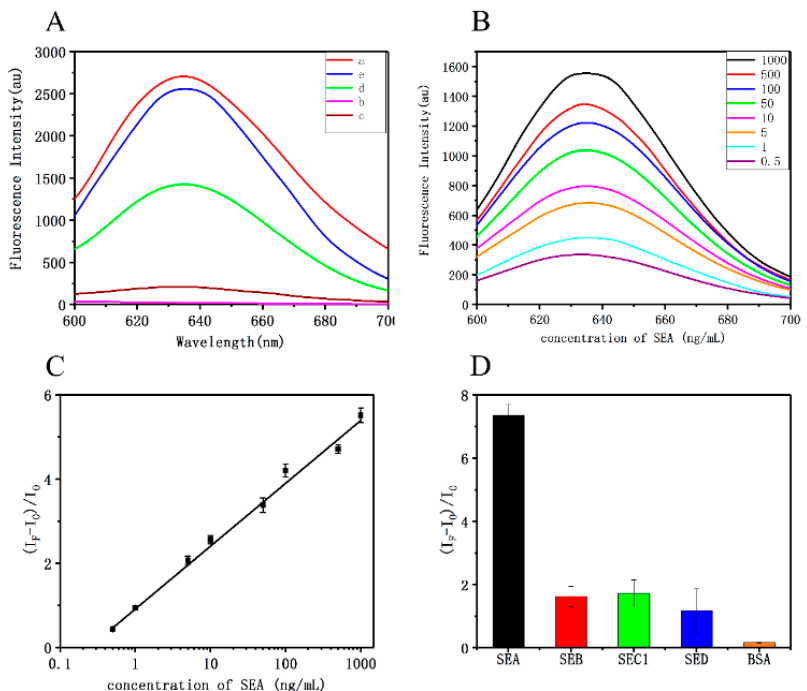
Figure 6. ( A ) Fluorescence emission spectra of C6G5C6-apt-AgNCs under various conditions: (a) C6G5C6-apt-AgNCs (b) PPyNPs (c) C6G5C6-apt-AgNCs + PPyNPs (d) C6G5C6-apt-AgNCs + PPyNPs + SEA (e) C6G5C6-apt-AgNCs + SEA (C6G5C6-apt-AgNCs, 2.4 μ M; PPyNPs, 8 mg/mL; SEA, 500 ng/mL). ( B ) Fluorescence spectra in the presence of increasing concentration of the target. ( C ) A linear relationship is obtained when the concentration of SEA is in the range of 0.5–1000 ng/mL. ( D ) Relative FI of the proposed bioassay for SEA and other toxins (SEB, SEC1, SED, bovine serum albumin